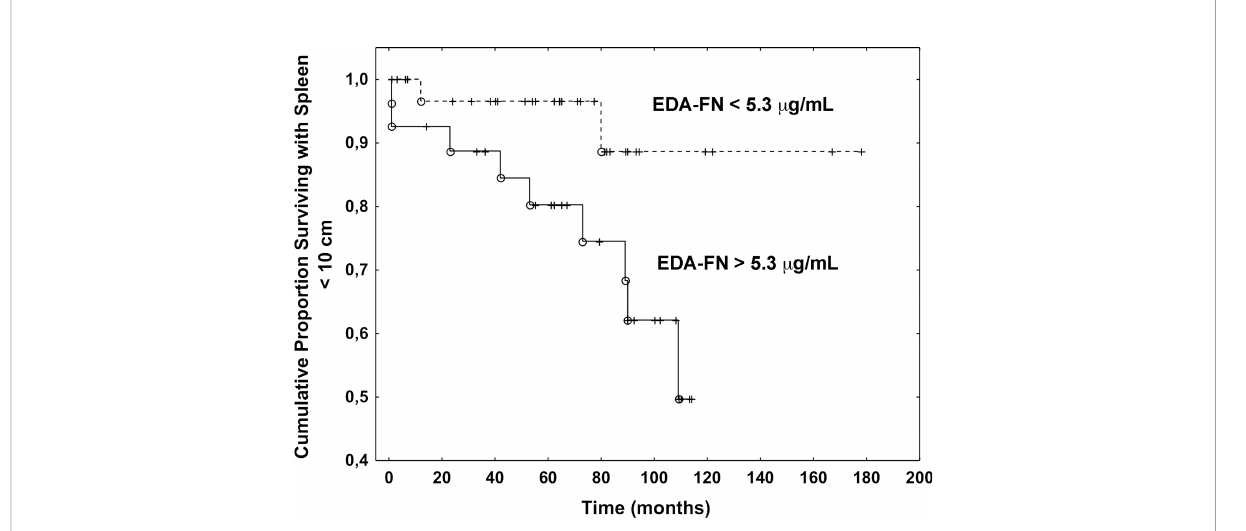
FIGURE 2 Plasma EDA-FN levels predict splenomegaly progression. Kaplan Meier analysis of the progression to large splenomegaly in patients with EDA- FN lower and greater than the cut-off value of 5.3 m g/mL. The difference was statistically signi fi cant